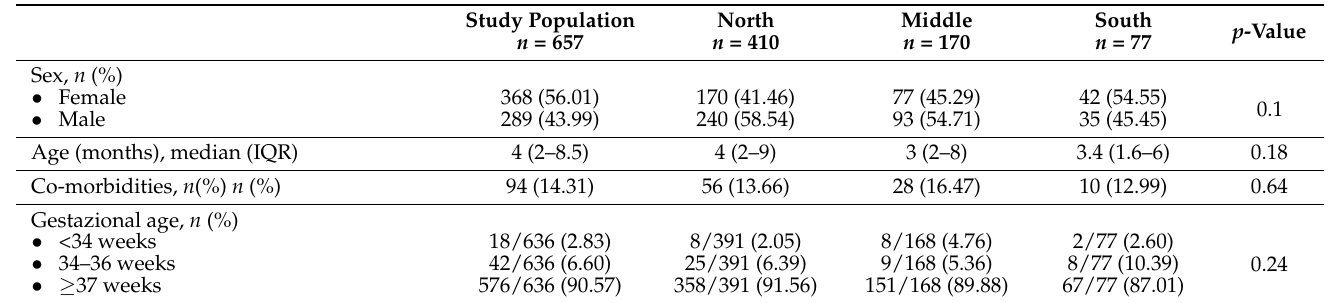
Figure 1. Temporal distribution of cases of bronchiolitis during the study period ( A ) and according to the main geographical areas ( B ). Table 1. Study population. CPAP, continuous positive airway pressure; PICU, pediatric intensive care